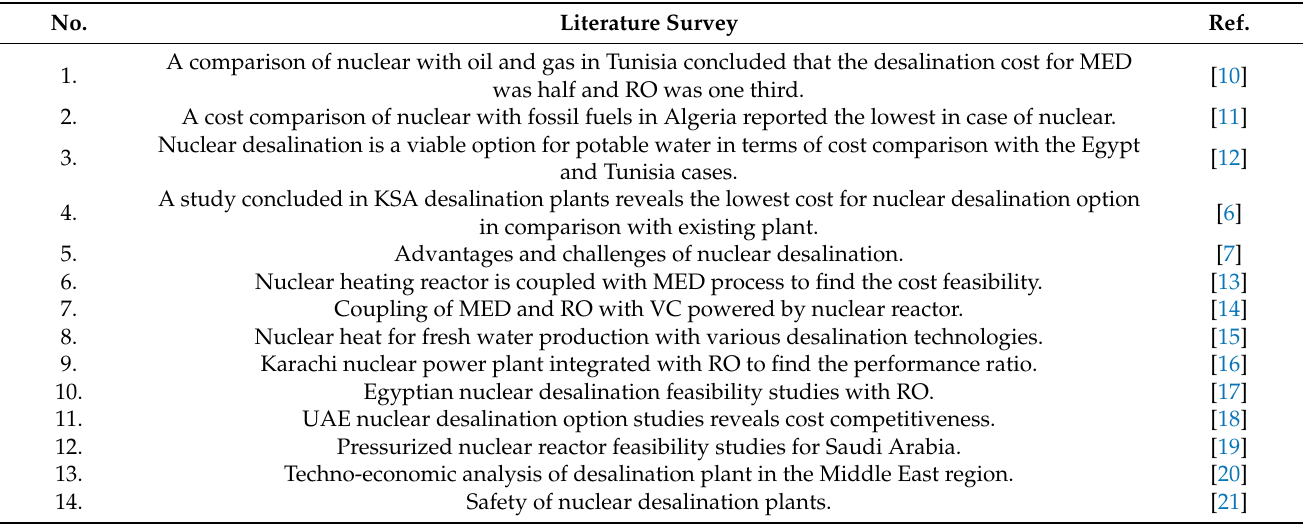
Table 1. Most up-to-date literature survey of nuclear